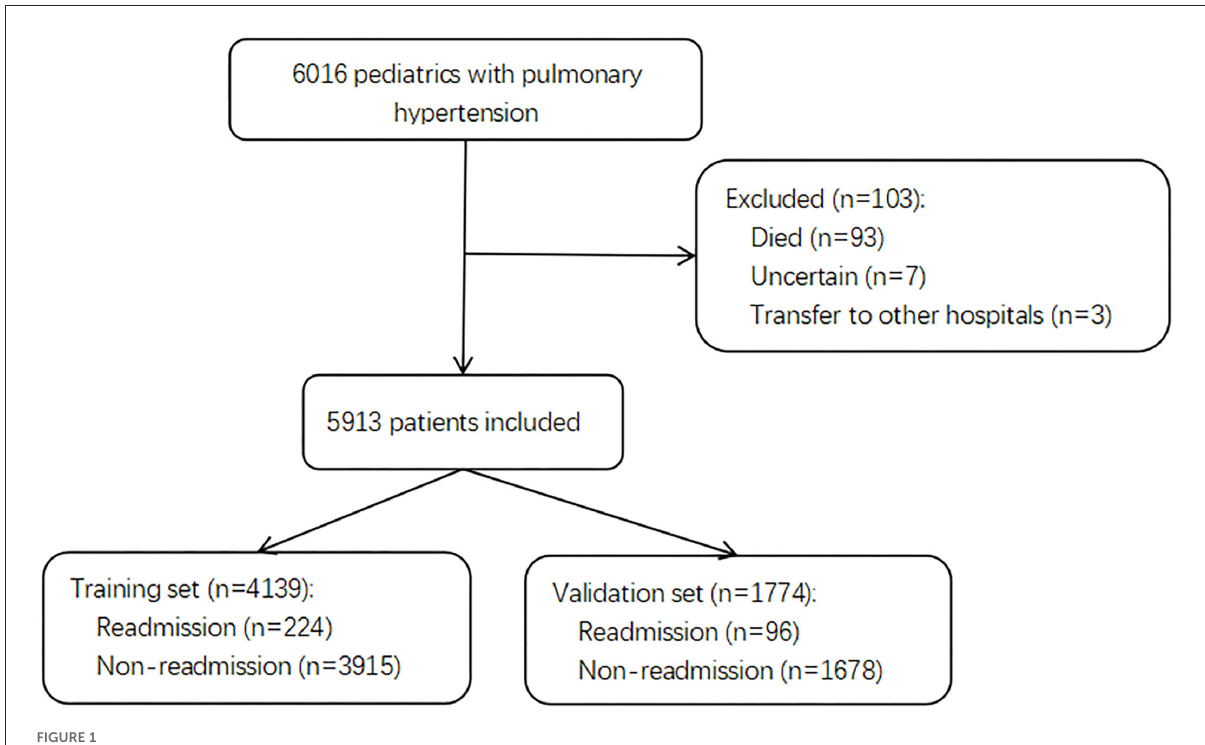
FIGURE1 The flowchart of the patient